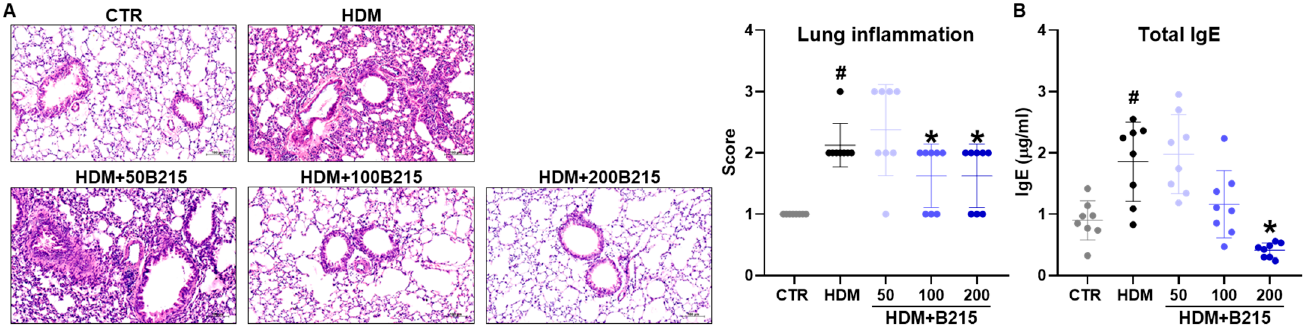
Figure 2. Histological and serological analysis showing the effect of B215 against HDM-induced lung inflammation. ( A ) Representative images of H&E-stained lung sections (Scale bar 100 µm) and inflammatory scores of lungs; ( B ) Plasma IgE levels in different groups. Gray, Control; Black, HDM; Light blue, HDM+50B215; Blue, HDM+100B215; Dark blue, HDM+200B215. Data are presented as mean ± SD (# and *, p < 0.05, compared to CTR and HDM, respectively).